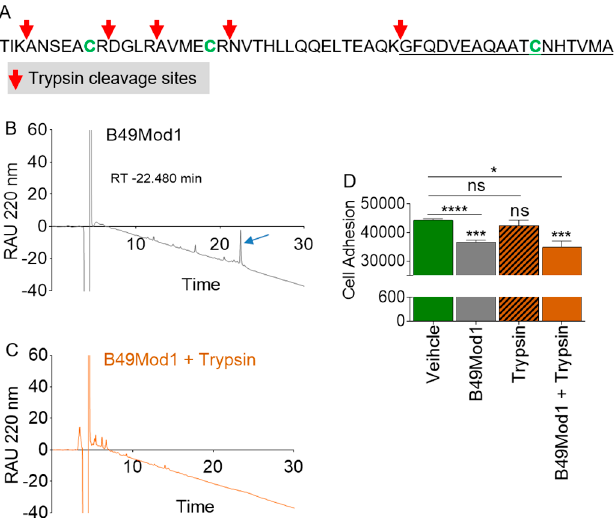
Figure 4. Proteolytic digestion of B49Mod1 using trypsin. ( A ) B49Mod1 sequence and predicted trypsin cleavage sites (red arrows). Reversed-phase high-performance liquid chromatography (RP-HPLC) analysis of ( B ) undigested B49Mod1 and ( C ) trypsin-digested B49Mod1. ( D ) Adhesion of 4T1 cells atop 4T1 monolayers treated with B49Mod1 or trypsin-digested B49Mod1. Experiments were repeated three times with similar results. Error bars represent S.E.M. Ordinary one-way ANOVA test (Dunnett’s correction), and two-tailed t-test (Welch’s correction) were used to determine the differences between the groups. * p < 0.05, *** p < 0.001, **** p < 0.0001, and ns, non-significant. Table 1. Sequence information and characteristics of B49Mod1 predicted fragments.